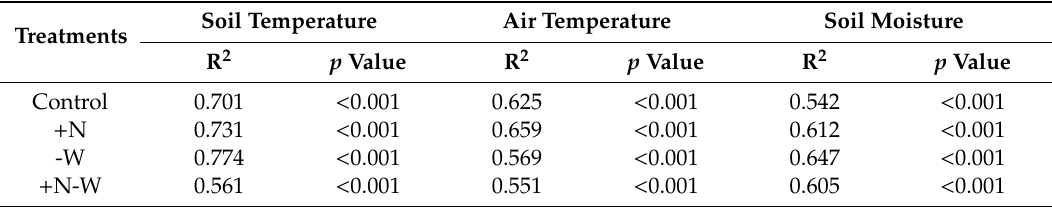
Table 2. The correlation coe ffi cients between nongrowing season soil respiration and soil temperature at 5 cm depth, air temperature, and soil moisture.